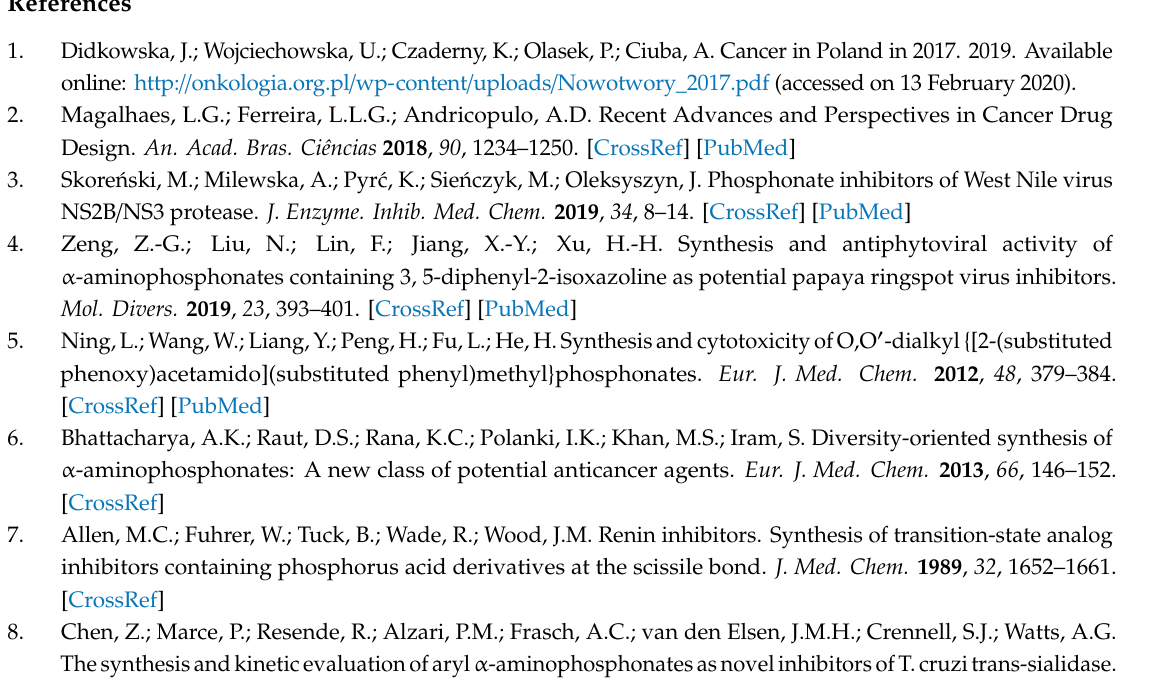
NMR and (c) 31 P NMR spectra of ethyl-[(1 R ,6 R )-3-oxo-2,5-diazabicyclo[4.4.0]dec-4-yl](phenyl)phosphinate 2d. Figure S6. (a) 1 H NMR, (b) 13 C NMR and (c) 31 P NMR spectra of (1 R ,6 R )-3-oxo-4-(diphenylphosphoryl)-2,5- diazabicyclo[4.4.0]decan 2e. Figure S7. (a) 1 H NMR, (b) 13 C NMR and (c) 31 P NMR spectra of (4-((3a R ,8a R